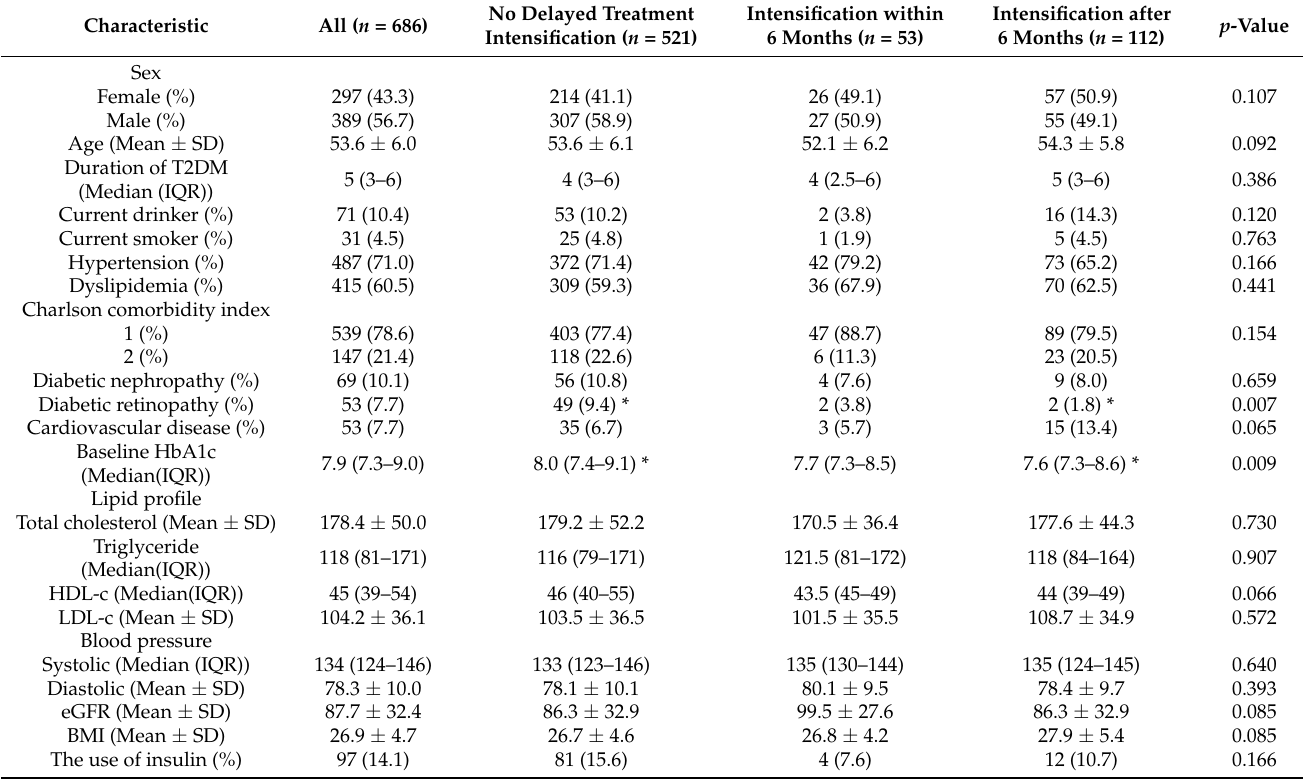
Table 1. Baseline